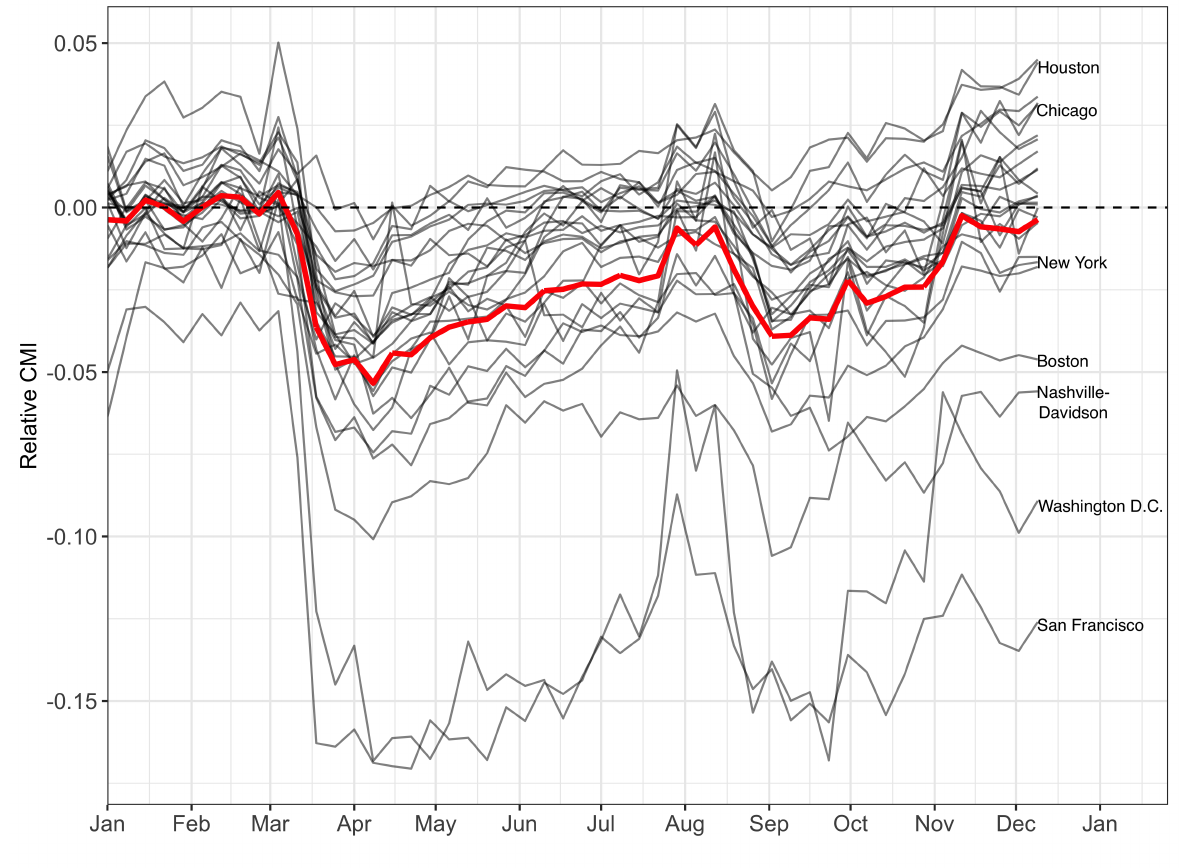
Figure 2: Weekly CMI relative to 2019 average. Each line represents changes in a single city, and the red line is the weekly